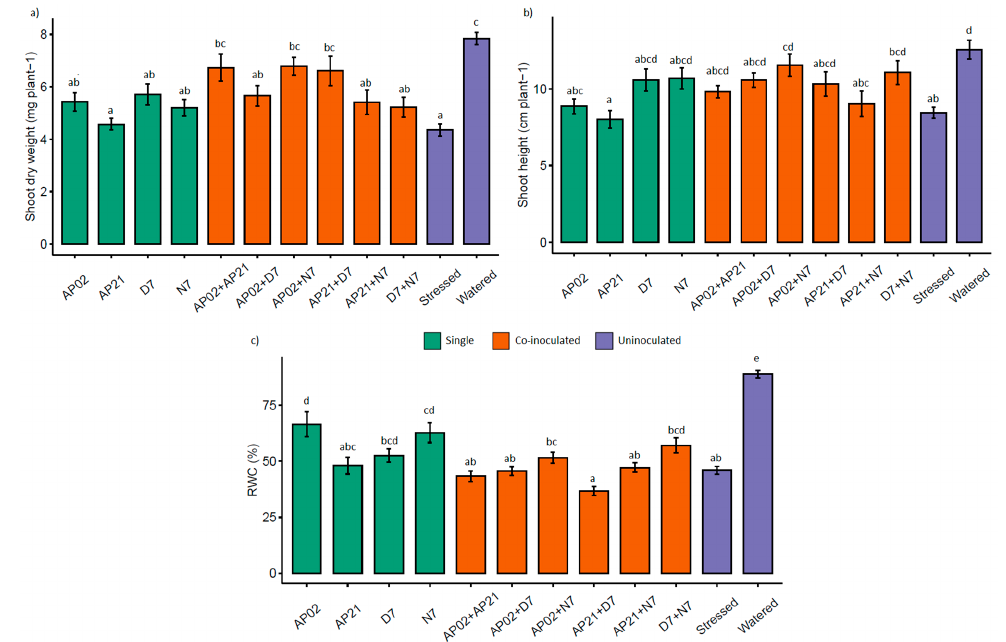
Figure 2. Response of perennial ryegrass plants after 10 days without irrigation. ( a ) Shoot dry biomass, ( b ) shoot height, and ( c ) relative water content (RWC). Bars represent the standard deviation of nine replicates. Different letters indicate that groups are significantly different according to the Kruskal–Wallis and pairwise comparison ( p < 0.05). AP02: Herbaspirillum sp.; AP21: Herbaspirillum sp.; D7: Azospirillum brasilense ; N7: Pseudomonas fluorescens.